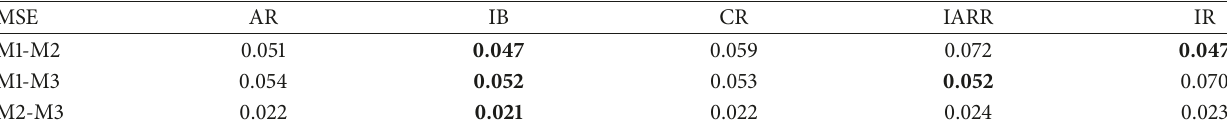
Table 5: The MSE value of two ranked lists of common objects in two datasets . For each pair of comparison, the lowest value is emphasized in bold.